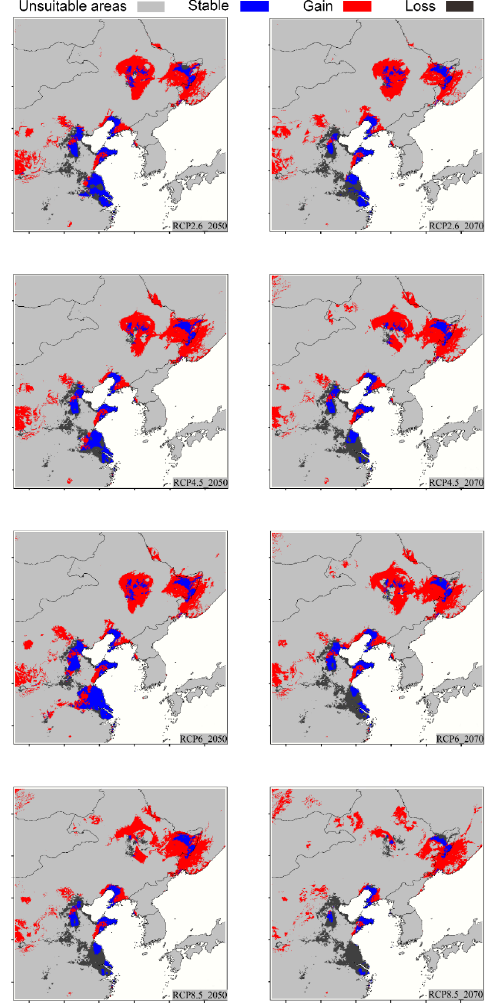
Figure 6. Future distribution of suitable habitats for Paradoxornis heudei . The blue areas are currently known to be suitable habitats and may remain so in the future. The red areas represent newly identified suitable habitats projected to emerge in the future. The black areas, which are currently suitable habitats, may become unsuitable due to climate